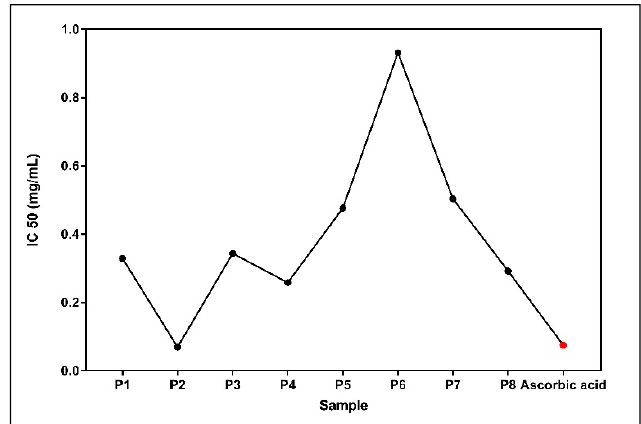
Figure 7. IC 50 variation among P1-P8 samples.